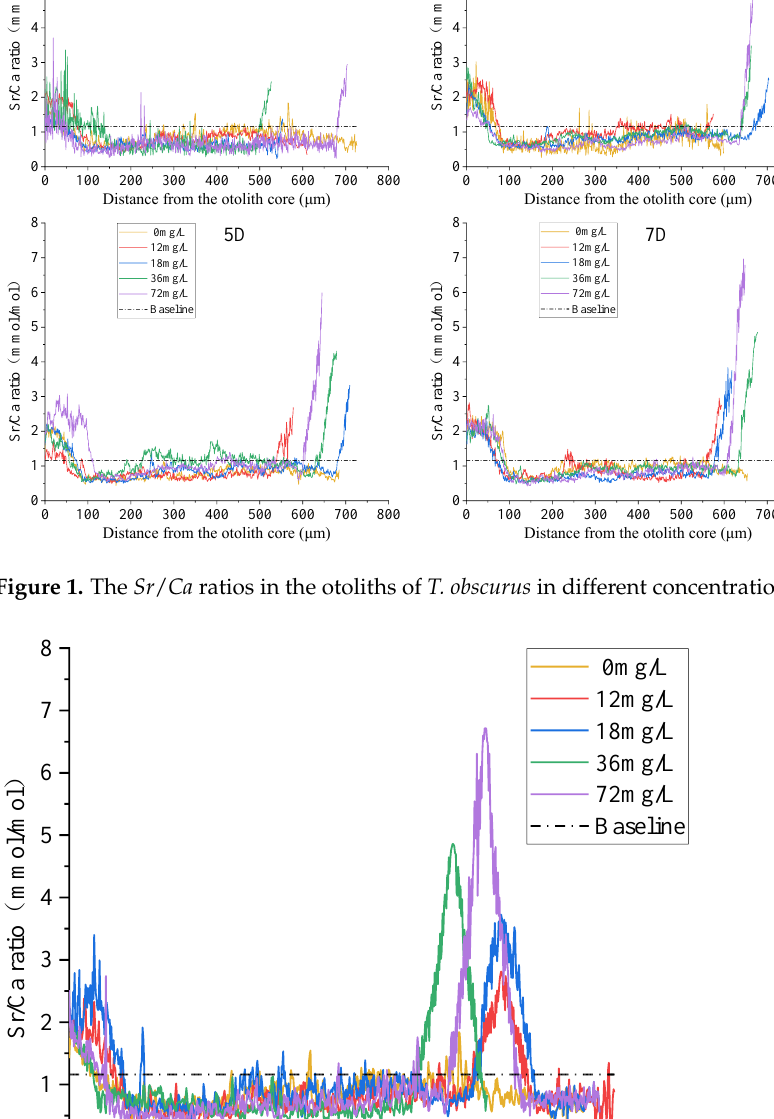
added strontium, the Sr / Ca ratio returned to the previous level. Thus, the success rate of